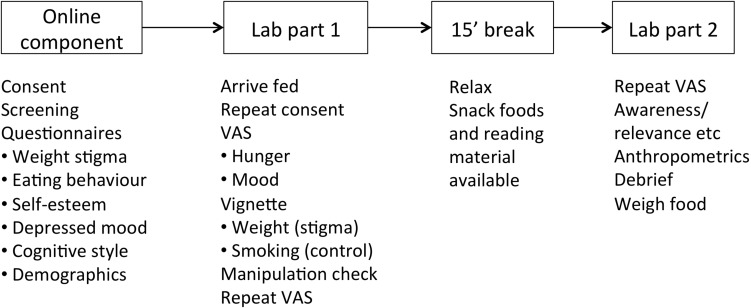
Schematic overview of study design.